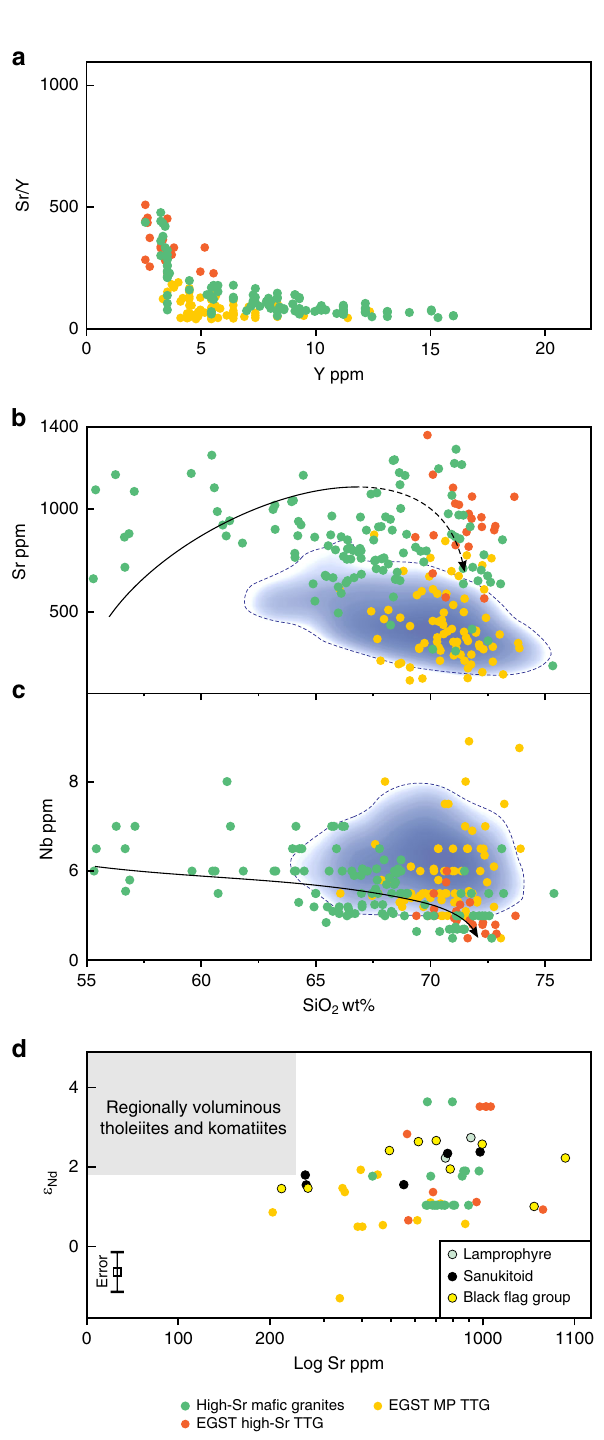
Post-Archean felsic crust forms in the mid- to lower crustal regions of continental arcs above subduction zones. Here, hydrated mantle-derived magmas intrude, crystallize and dehy- drate, and melt and mix with pre-existing, evolved and compo- sitionally heterogeneous crustal sources 51 . Melting conditions vary between those of water- fl uxed melting 51 and fl uid-absent reactions consuming biotite, but hornblende-bearing felsic melts are common.